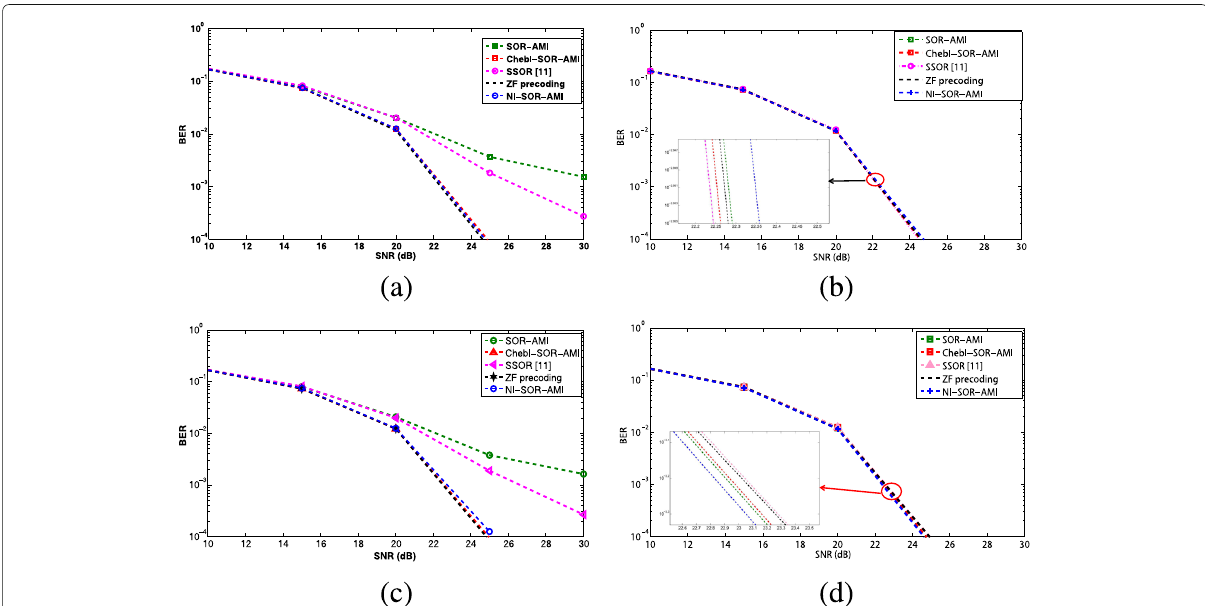
Fig. 4 BER performance comparison between SSOR, NI-SOR-AMI, and ChebI-SOR-AMI method N × K = 256 × 32 mMIMO system for uncorrelated and correlated channel conditions. This figure compares SOR-AMI, ChebI-SOR-AMI, and NI-SOR-AMI with conventional SOR and SSOR methods under correlated and uncorrelated channel conditions for the second and fourth iterations. a Uncorrelated channel, i = 2. b Uncorrelated channel, i = 4. c Correlated channel, i = 2. d Correlated channel, i = 4